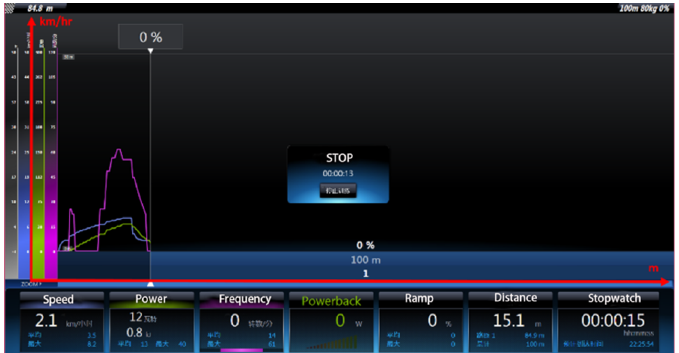
Figure 16. Results for flat road, cyclist weight 80 kg, and lower-arm three-phase short-circuit braking.